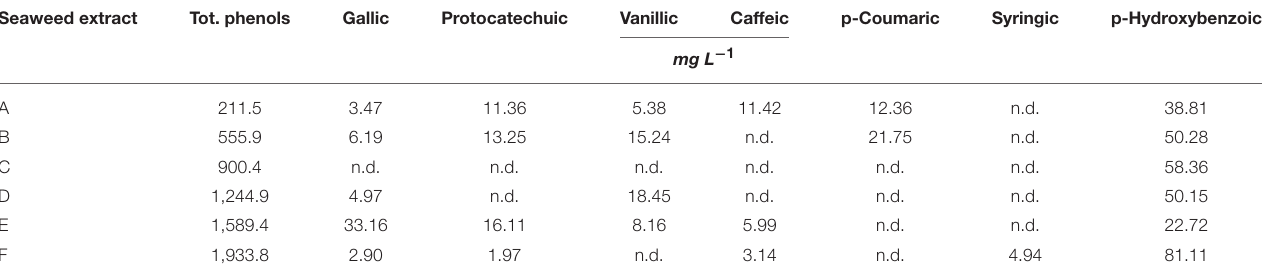
TABLE 3 | Hormone-like activity of extracts obtained from the seaweeds Laminaria (A) and Ascophyllum nodosum spp. (B–F). Seaweed extract IAA-like activity GA-like activity (ppm IAA) (ppm GA) 0.01